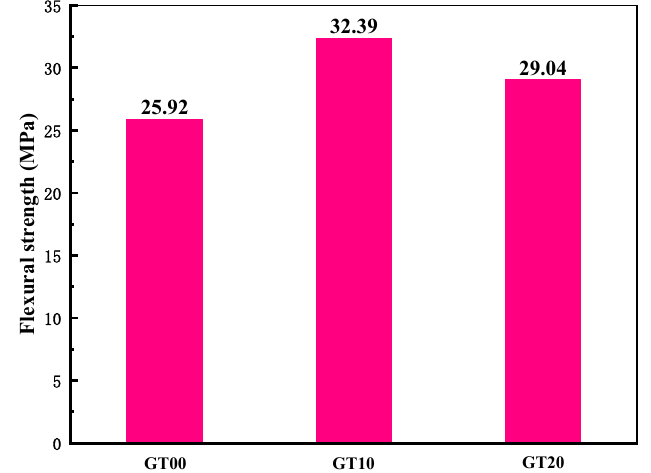
Figure 16. Flexural strength.